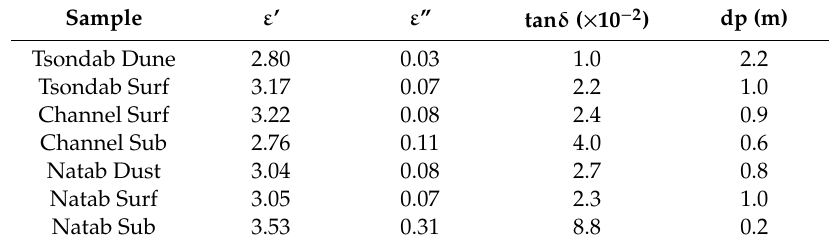
Table 1. Dielectric constant (real part ε ’ and imaginary part ε ”), loss tangent and skin depth at 1.2 GHz for surface and subsurface sediments at Tsondab and Natab study